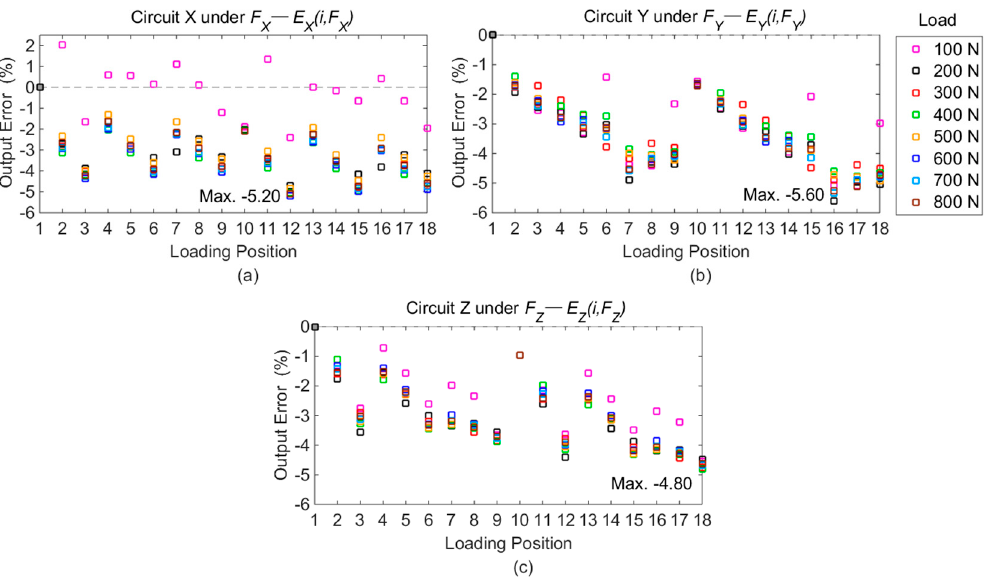
Figure 8. Output errors on different loading points compared with Point 1: ( a ) errors in Circuit X under